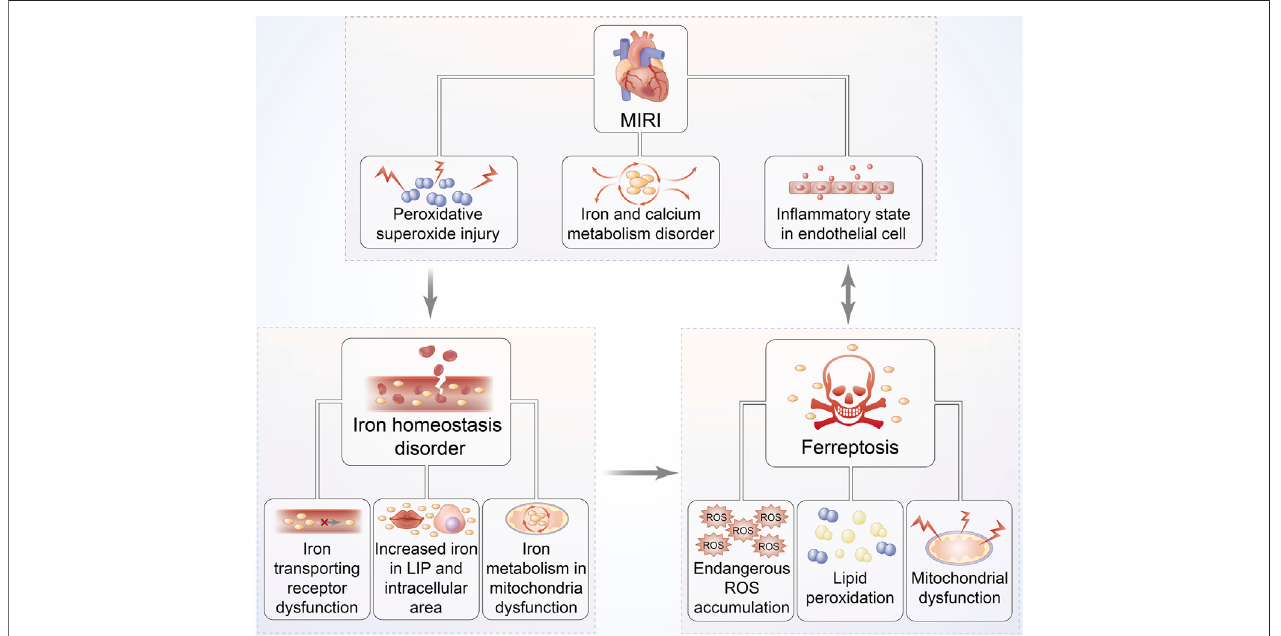
FIGURE4| RelationshipbetweenMIRIand ironhomeostasisdisorder aswellasferroptosis. Thepathophysiological progressionofMIRIisclosely associated with iron homeostasis disorder, overproduction of ROS, and mitochondrial dysfunction, followed by increased iron accumulation. These responses can further trap cardiac cells intoaviciouscycle ofexacerbated ROS-induced impairment,eventuallyleadingtoferroptosis. Heartssuffering I/R injuryare exposed topersistent oxidative stress, especially iron-dependent lipid hydroperoxide generation, which might damage the contractility of cardiomyocytes.